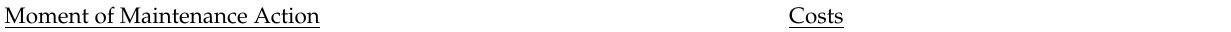
Table 6. Annualized cost of maintenance for the first maintenance strategy (MS1), considering a time horizon of 40 years.